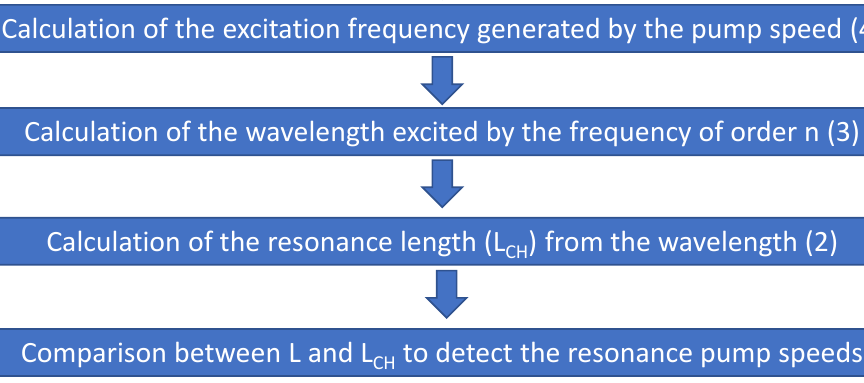
Figure 3. Steady state algorithm.